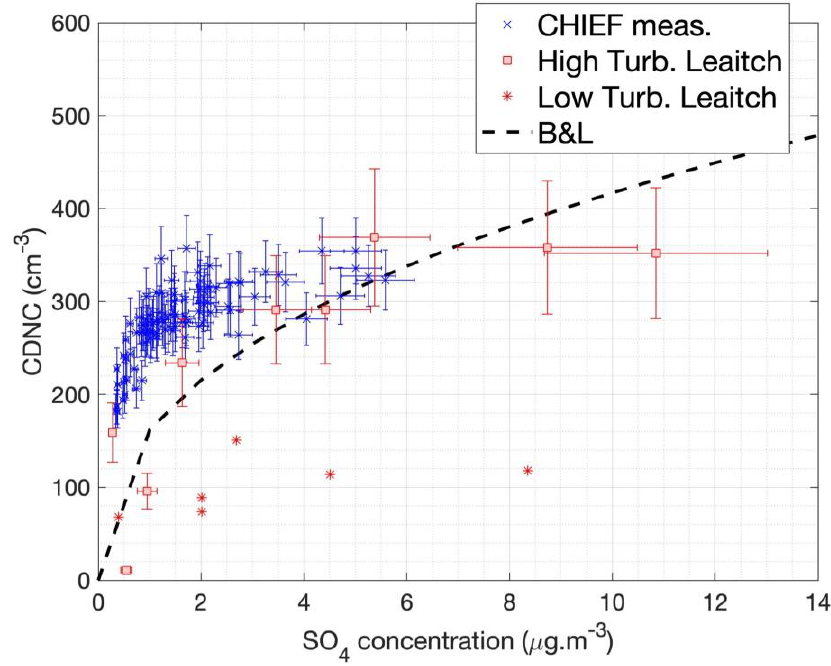
Figure 2. CDNC as a function of sulfate concentration measured in the CHIEF cloud chamber (blue cross) and observed during the stratocumulus flights of Leaitch et al. [23] (red squares and stars). The dashed line represents the Boucher and Lohmann [22] parameterization.